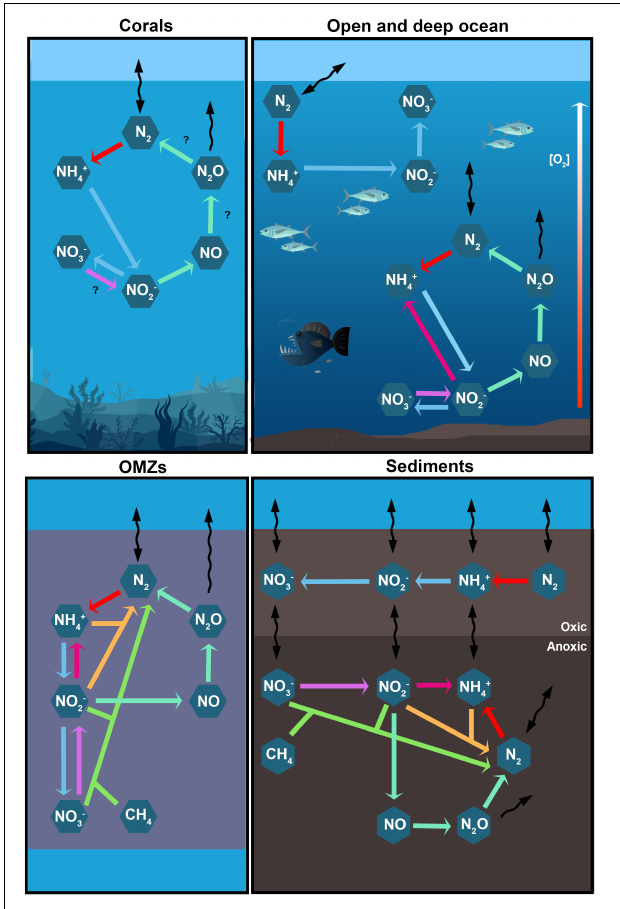
FIGURE 2 | The main studied processes of the N cycle in different marine environments. Every colored arrow represents a N transformation: N 2 fixation (red), nitrification (light blue), nitrate reduction (violet), DNRA (magenta), denitrification (aquamarine), N-damo (green), and anammox (orange). Black curved arrows represent physical processes such as advection and